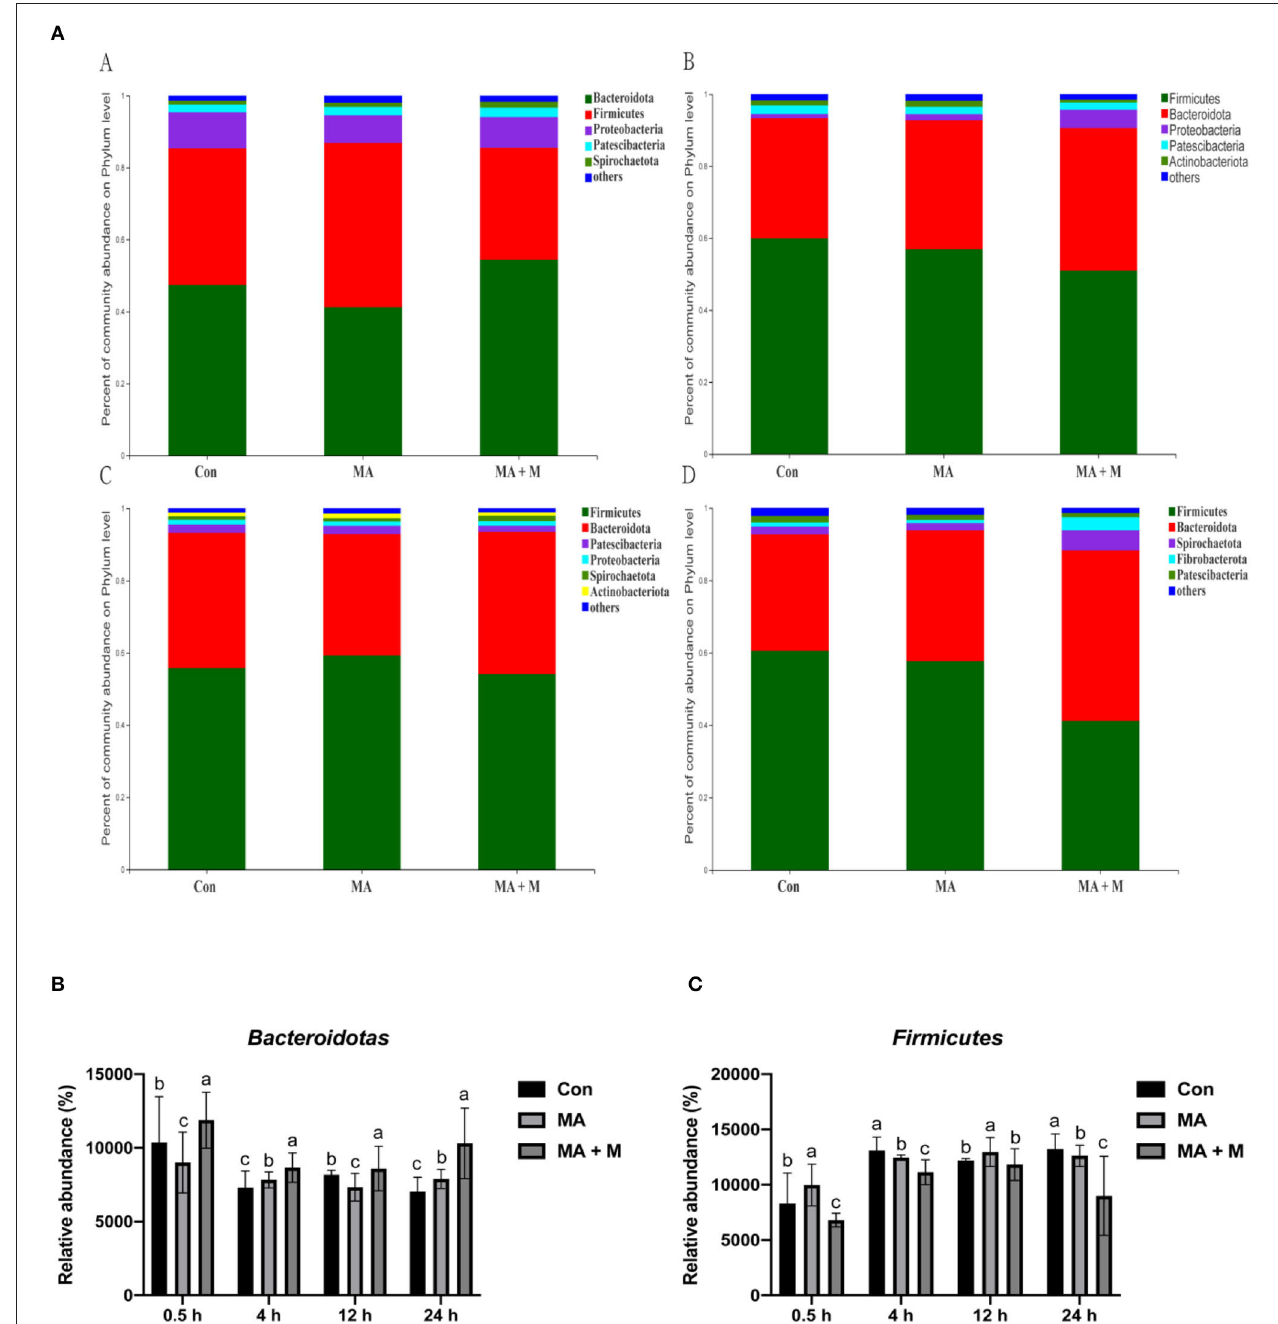
FIGURE 6 | The relative abundance of microbial species under different pretreatment groups. (A) Histogram of the relative abundances of species of the rumen microbiome in all pretreatments at the phylum level (abundances < 0.01 were grouped as “others”). (B) The relative abundance of Bacteroidotas in all pretreatments. (C) The relative abundance of Firmicutes in all pretreatments. Con, no additive, control; MA, added microecological agents; MA + M, a combination of microecological agents and molasses. Different superscript letters a, b, and c indicate significantly different values ( P < 0.05) in different groups and the same or no letters indicate insignificant differences ( P >